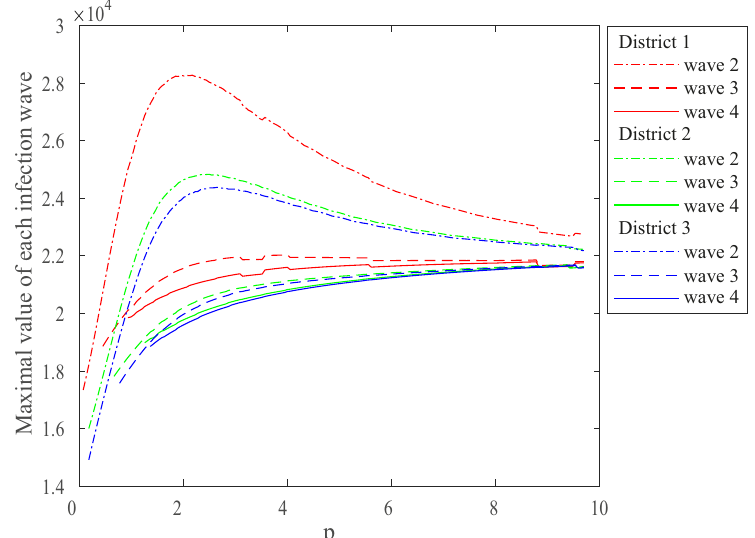
Figure 3. The dependence of the maximum number of infected in the second and subsequent waves in districts (red—1, green—2, blue—3) on the degree of openness of the boundaries between the hub and other districts (p).